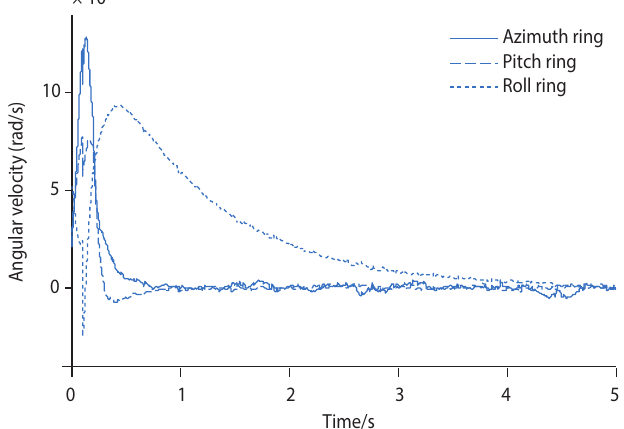
Figure 4. Parameter certainty and disturbances exiting response